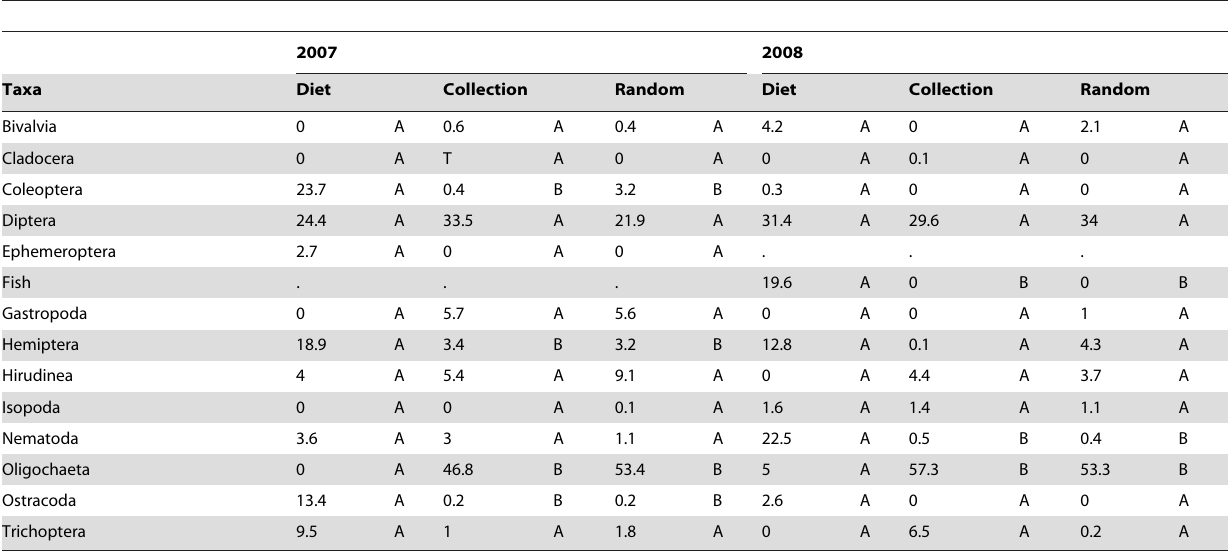
*Values with different letters within rows indicate significant differences of least-squares means (Tukey-Kramer test: P # 0.05) within that year. T indicates a trace amount of material present.